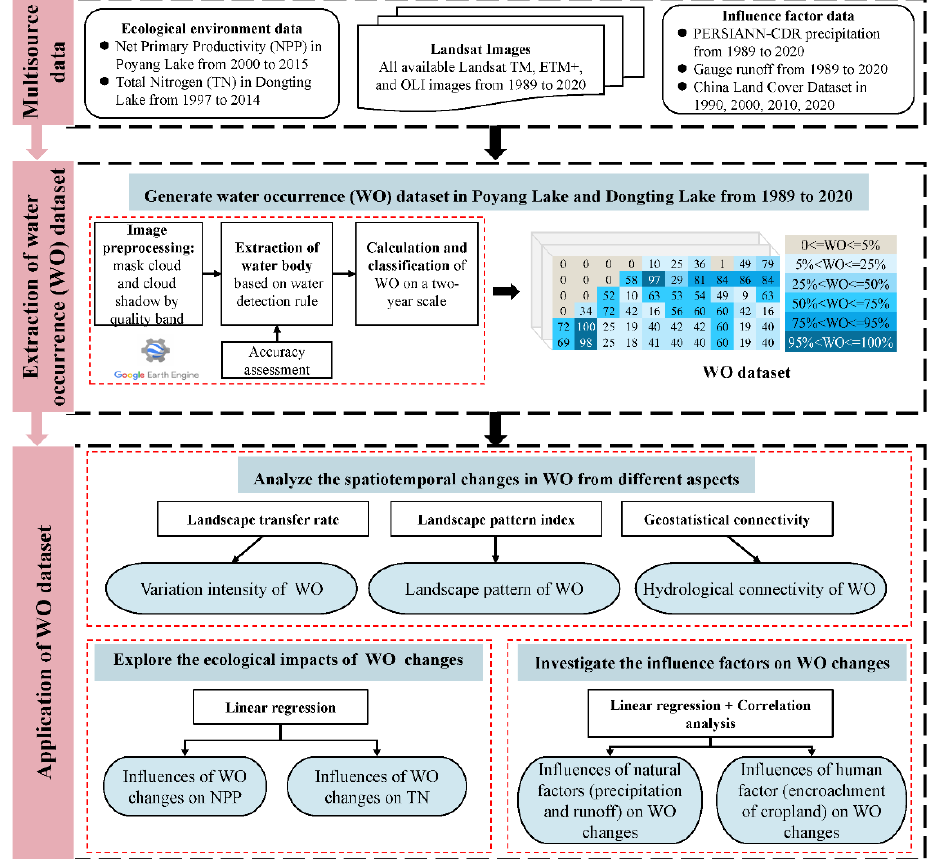
Figure 2. The research framework of the